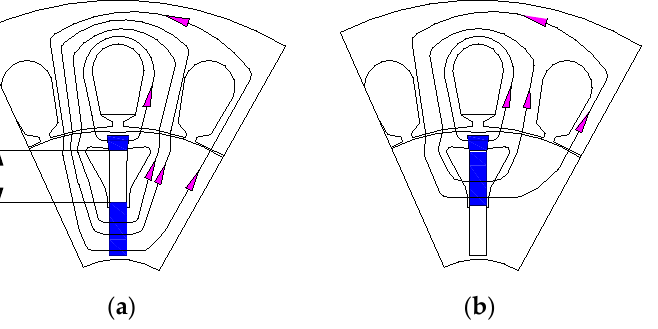
Figure 2. The magnetic flux path: ( a ) operating at or below the rated speed ( s = 11 mm); ( b ) operating above the rated speed ( s = 0 mm).